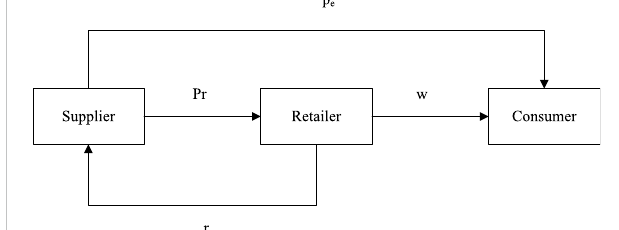
FIGURE 2 Retailer fi nancing strategy.